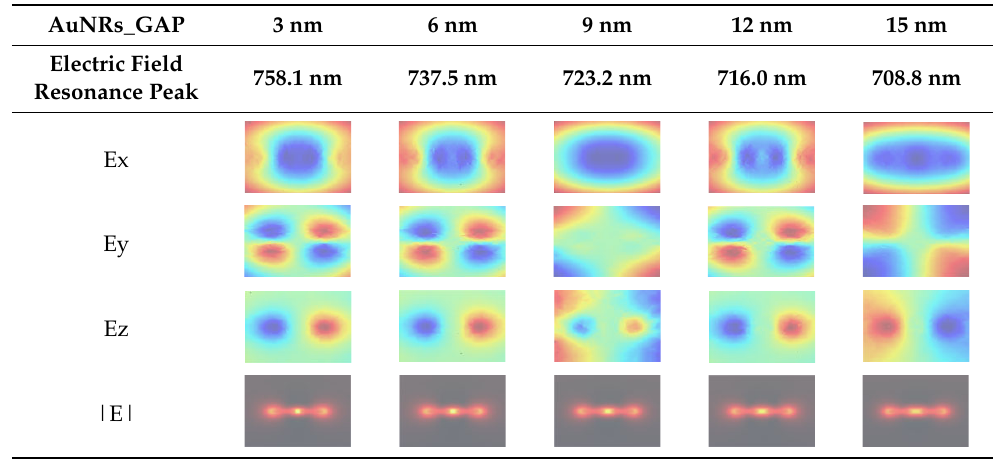
Table 5. Electric field distribution under the resonance peak of the gold nanorod dimer in the lon ‐ gitudinal structure (Y ‐ X section).